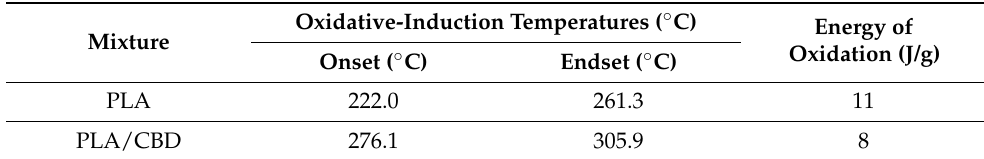
Table 4. Oxidative-induction temperature values of polylactide (PLA) and PLA with cannabidiol (CBD) content before weathering and their oxidation